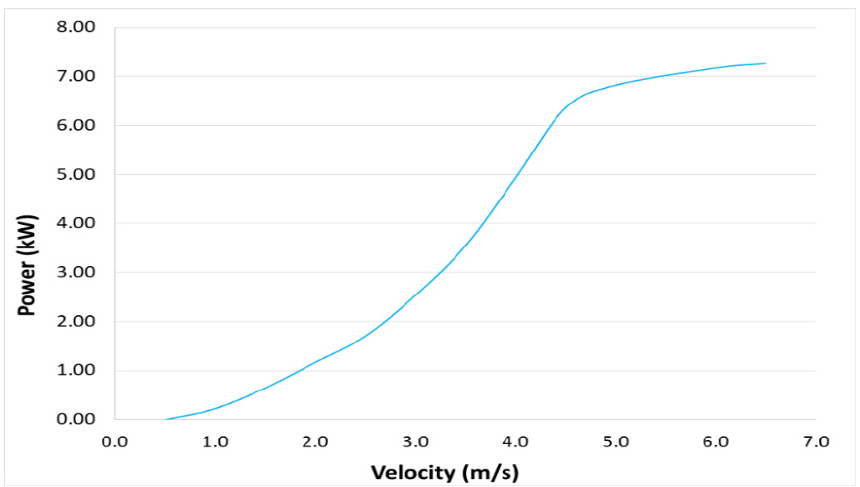
Figure 12. Power output vs. velocity for selected turbine design.